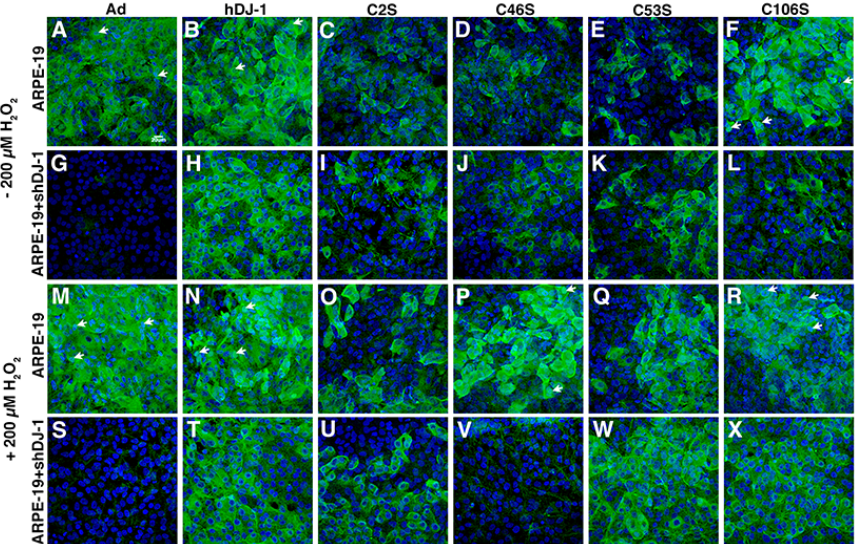
Figure 2. Under oxidative stress conditions, ARPE ‐ 19 monolayers transduced with the several DJ ‐ 1 constructs displayed visually higher immunoreactivity for DJ ‐ 1. ( A – F ) ARPE ‐ 19 and ( G – L ) ARPE ‐ 19 + shDJ ‐ 1 monolayers stained with DJ ‐ 1 (green) in baseline conditions. ( M – R ) ARPE ‐ 19 and ( S – X ) ARPE ‐ 19 + shDJ ‐ 1 monolayers stained with DJ ‐ 1 (green) under conditions of oxidative stress; blue: TO ‐ PRO ‐ 3. Arrows = nuclear localization. Bar = 20 μ m. A qualitative comparison between ARPE ‐ 19 and ARPE ‐ 19 + shDJ ‐ 1 displayed visu ‐